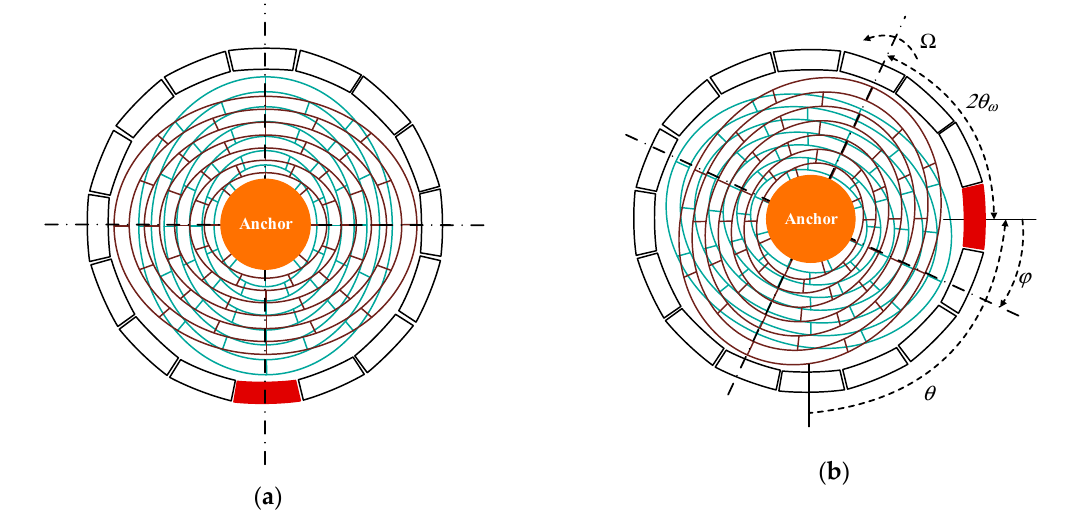
Figure 2. ( a ) Vibration mode of the stationary DRG, ( b ) Vibration mode of the rotating DRG.